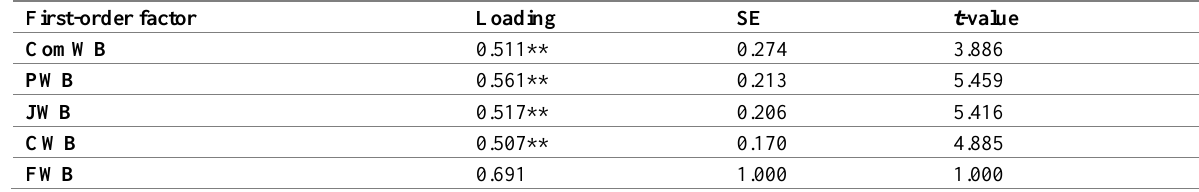
Table 5: Standardized loadings of first-order factors on the second-order factor of social well-being (SWB).